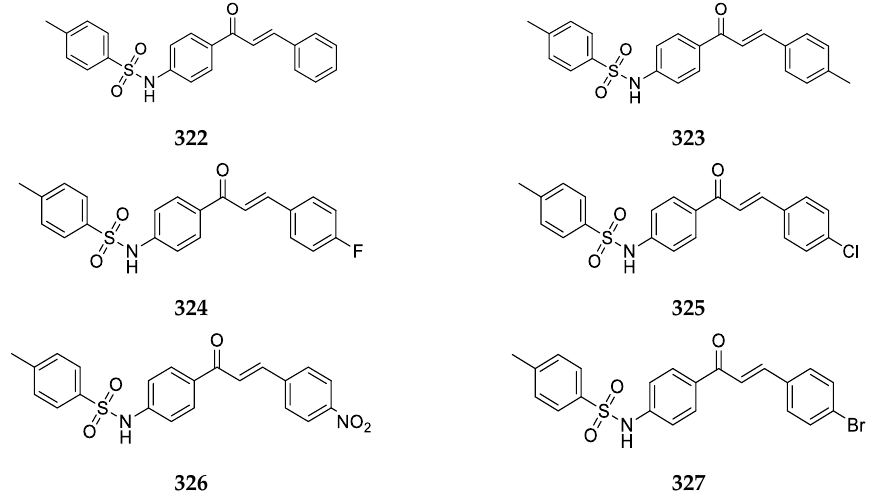
Table 37. In vitro cytotoxic effects of compounds 316 – 321 against human colon carcinoma cells